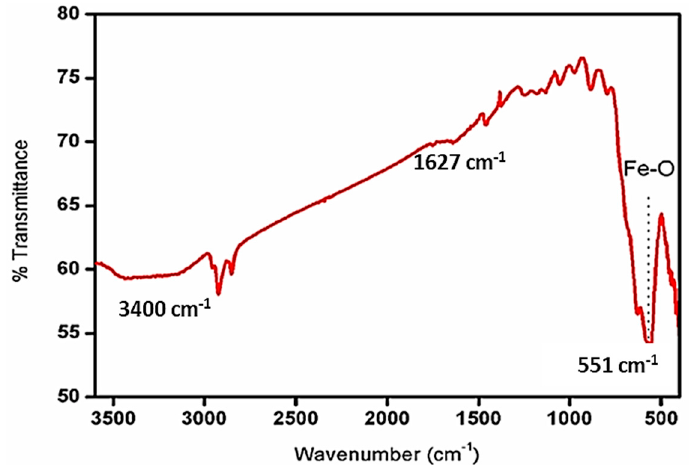
Figure 3. FTIR Spectra of IONPs.